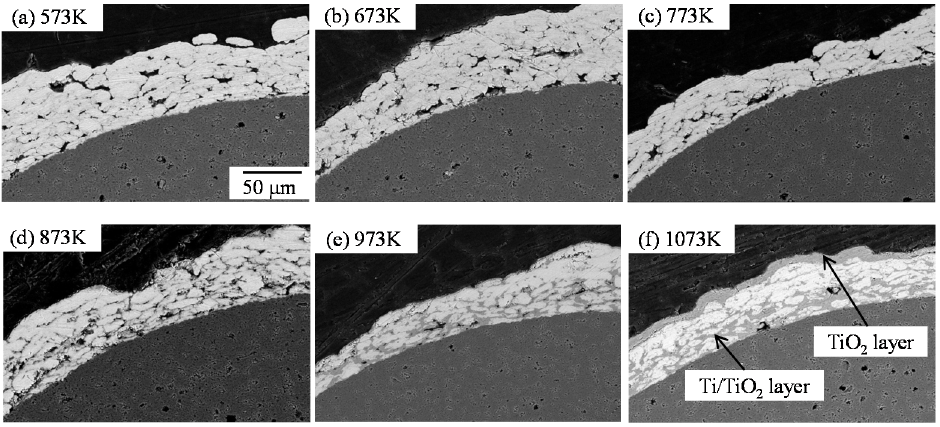
Figure 27. SEM images of cross sections of M10- x K-3h samples.